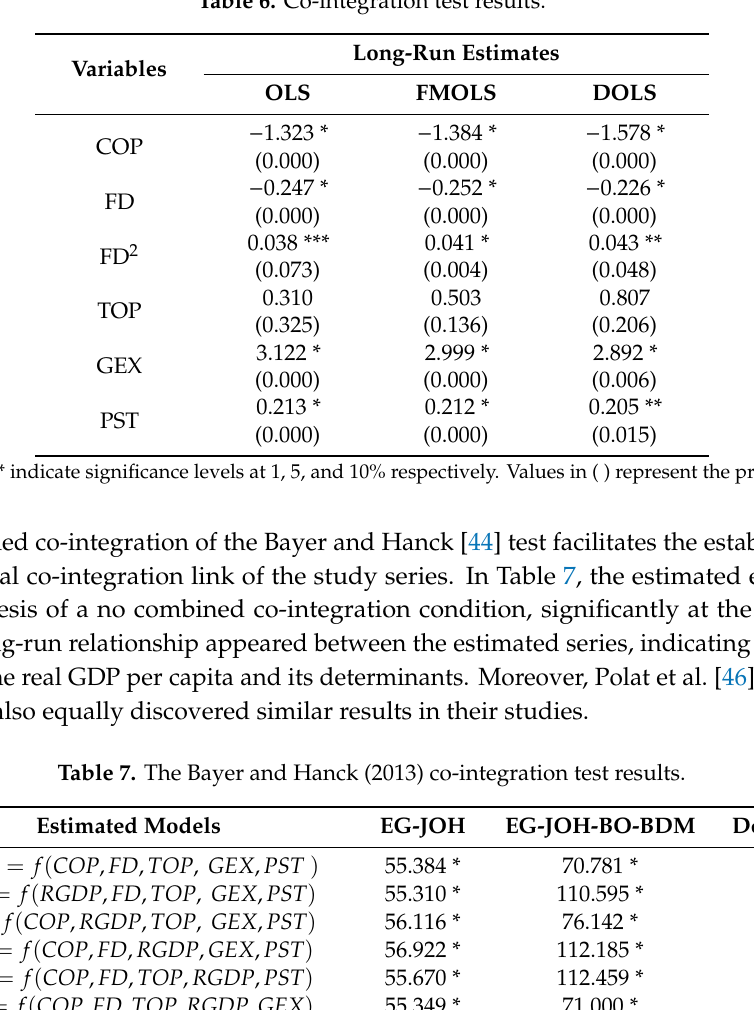
Table 6. Co-integration test results.